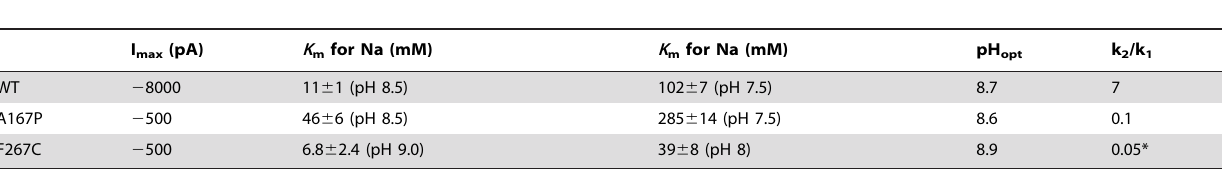
I max =average values for transient currents at pH opt and saturating Na concentration, pH opt =pH of largest current at 100 mM Na + , k 2 /k 1 = ratio of rate constants of H + translocation (k 2 ) to Na + translocation (k 1 ). Values for WT and A167C from [15] and [16], values for F267C from electrophysiological experiments described in this report. (*) estimated by adjustment of simulation to data in Fig. 5B.